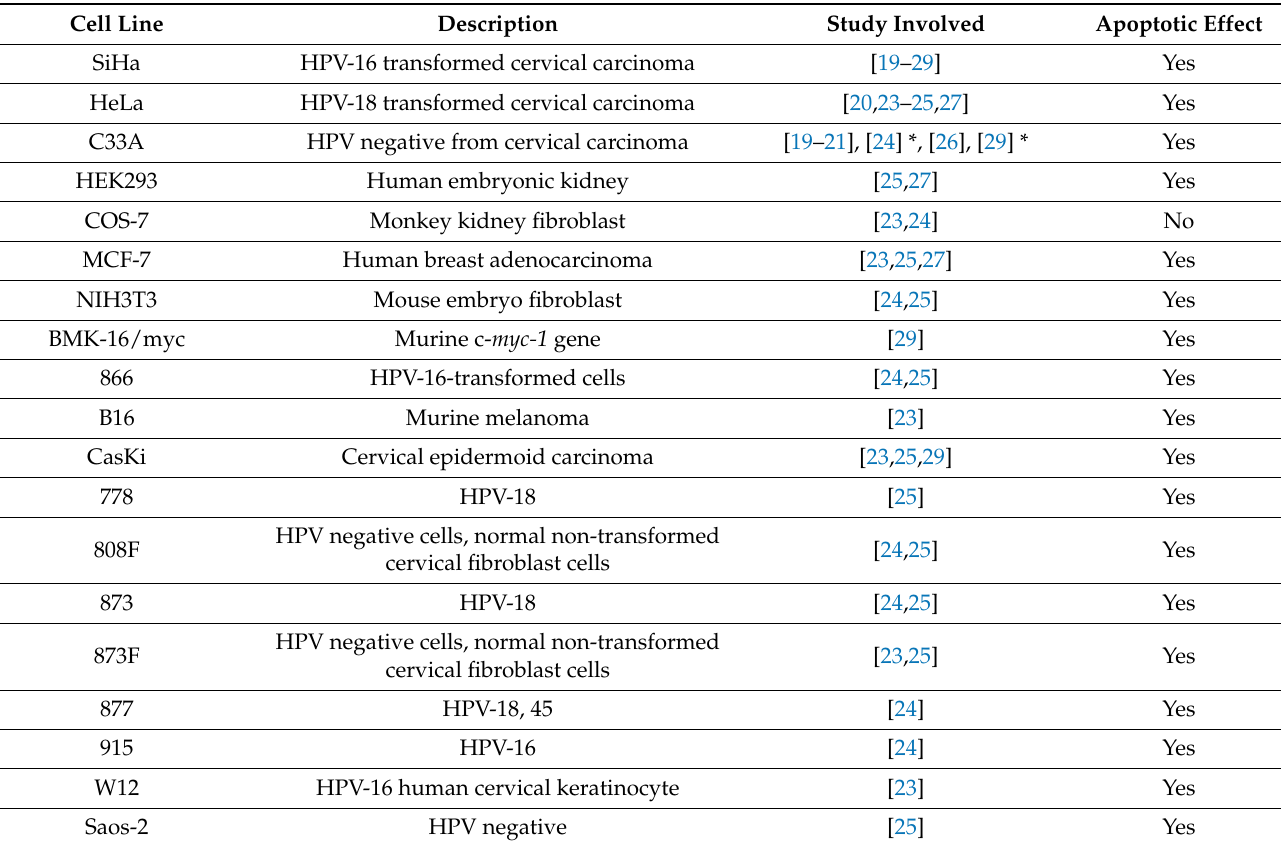
Table 2. Summary of cell lines that have been used in 11 studies. Stated together is the cell line apoptosis response after HPV-16 E2